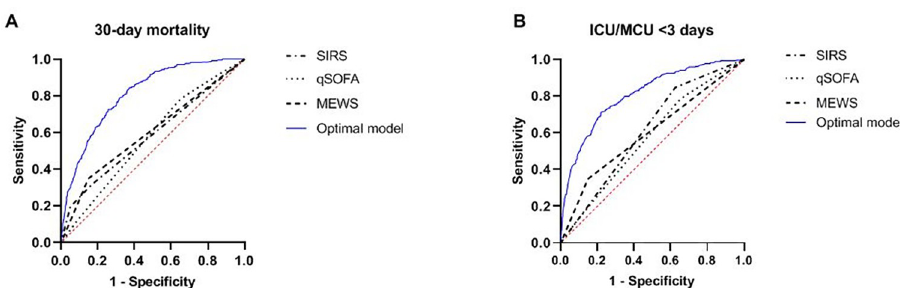
Fig 2. ROC curves of the prediction of 30-day mortality (A) and ICU/MCU admission within 3 days after ED presentation (B). The optimal model consisted of the following parameters: cv-ALL of monocytes, age, sex, CCI, respiratory rate, systolic blood pressure, Glasgow Coma Scale, heart rate, leukocyte count, and body temperature. The AUC of the optimal model for prediction of 30-day mortality was 0.81 and for ICU/MCU admission < 3 days 0.81 as